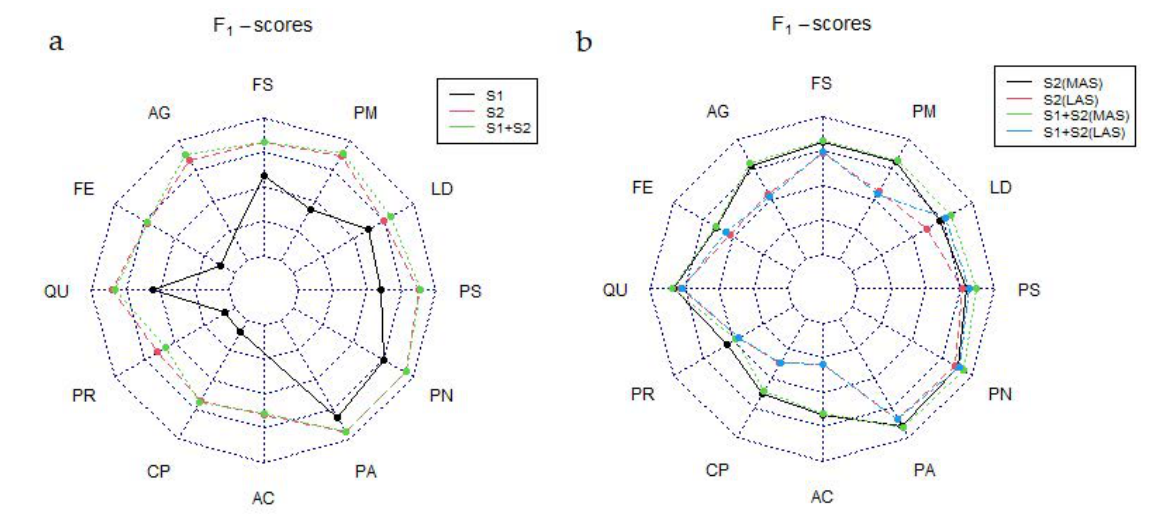
Figure 4. F 1 -scores of Test cases 1 to Test case 3 ( a ), F 1 -scores of all expressions of Test cases 6 to Test case 9 ( b ); for the abbreviations of tree species names see Figure 1, and definitions of test cases are provided in Table